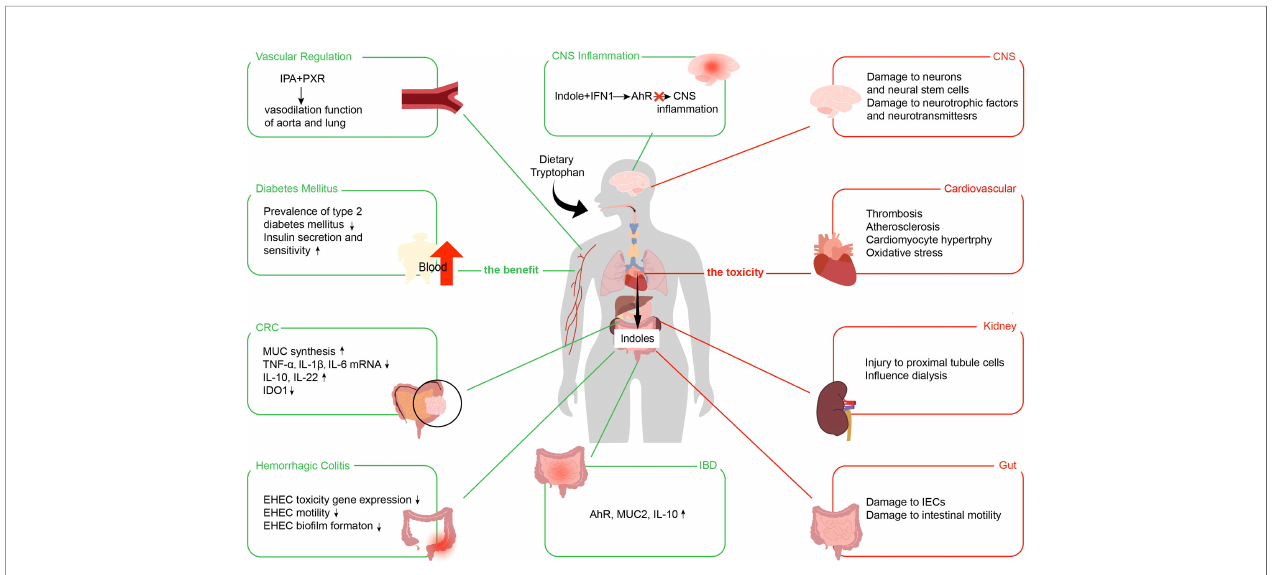
FIGURE 4 | Bene fi ts and toxic effects of indoles. The bene fi ts of indoles use the green line. The toxicities of indoles use the red line. IPA, indole 3-propionic acid; PXR, pregnane X receptor; IFN, type I interferon; AhR, aryl hydrocarbon receptor; CNS, central nervous system; CRC, colorectal cancer; MUC, mucin; TNF- a , tumor necrosis factor- a ; IL, interleukin; IDO1, indoleamine 2,3-dioxygenase; EHEC, enterohemorrhagic Escherichia coli ; IBD, in fl ammatory bowel disease; IECs, intestinal epithelial